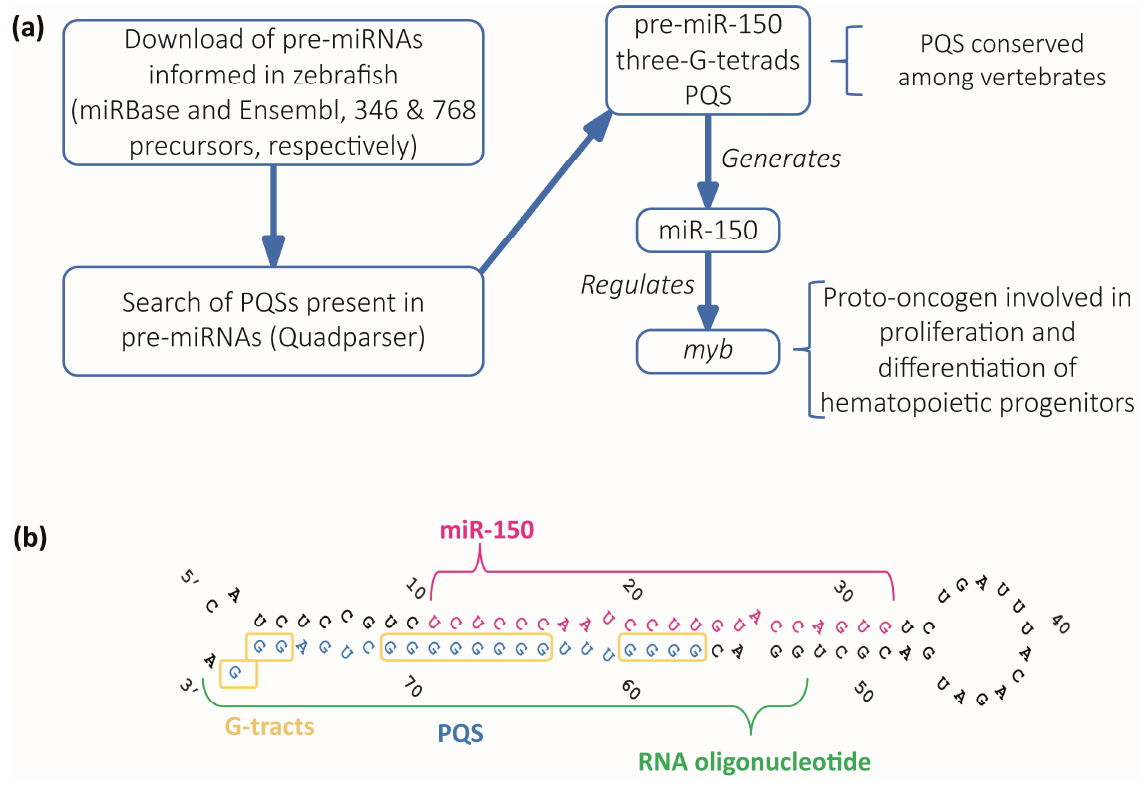
Figure 1. Identification and selection of pre-miRNAs containing PQSs. ( a ) Diagram of the computational search strategy of zebrafish pre-miRNAs sequences containing PQSs. ( b ) Sequence and stem-loop structure of zebrafish pre-miR-150. The mature miR-150 sequence (pink), the PQS (blue), the synthetic RNA oligonucleotide used in subsequent experiments (green), and the G-tracts (yellow boxes) are detailed.